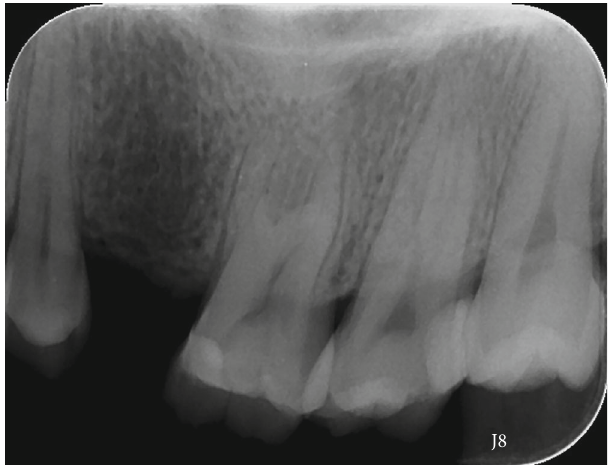
Figure 1: Preoperative radiograph.